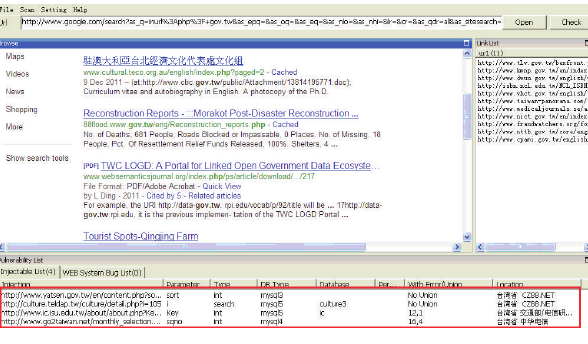
Figure 3: Official websites detection.